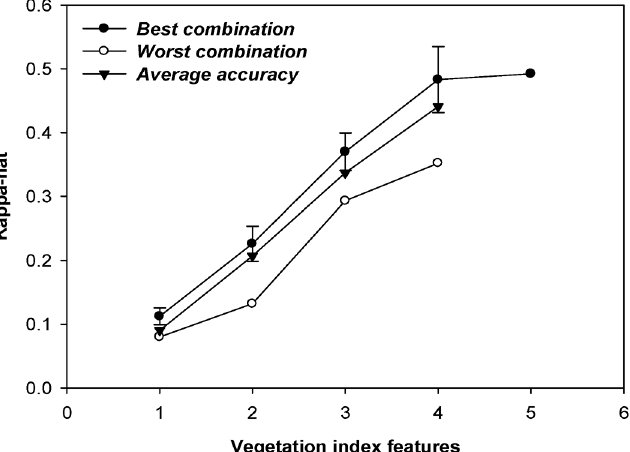
Fig 4. Relationship of classification accuracy using dataset 2 with various numbers of used VI